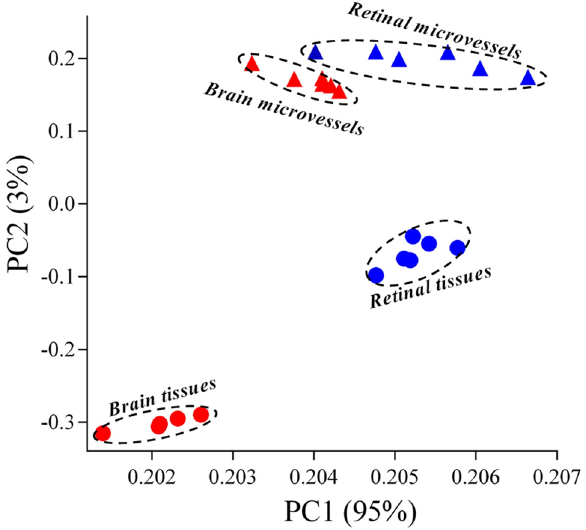
Figure 1. Principal component analysis (PCA) performed on whole transcriptome genes identified from RMVs, BMVs, RT and BT of rats. The first component (PC1) with a variance of 95% is on the X-axis and the second component (PC2) with a variance of 3% is on the Y-axis. Each dot represents one tissue sample. RMVs, retinal microvessels; BMVs, brain microvessels; RT, retinal tissue; BT, brain